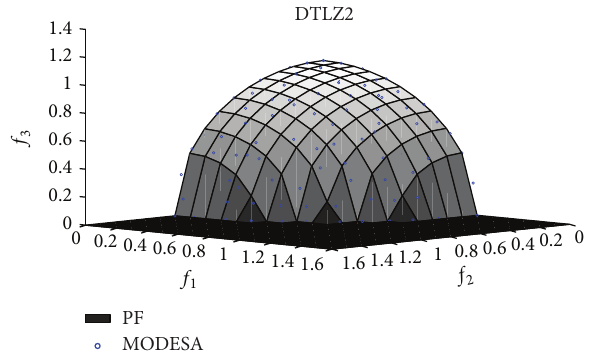
Figure 7: Plots of the nondominated solutions with the lowest IGD- metric values found by MODEA in 10 runs in the objective space on DTLZ1 where 𝑁 = 100 and 𝑇 = 250 .